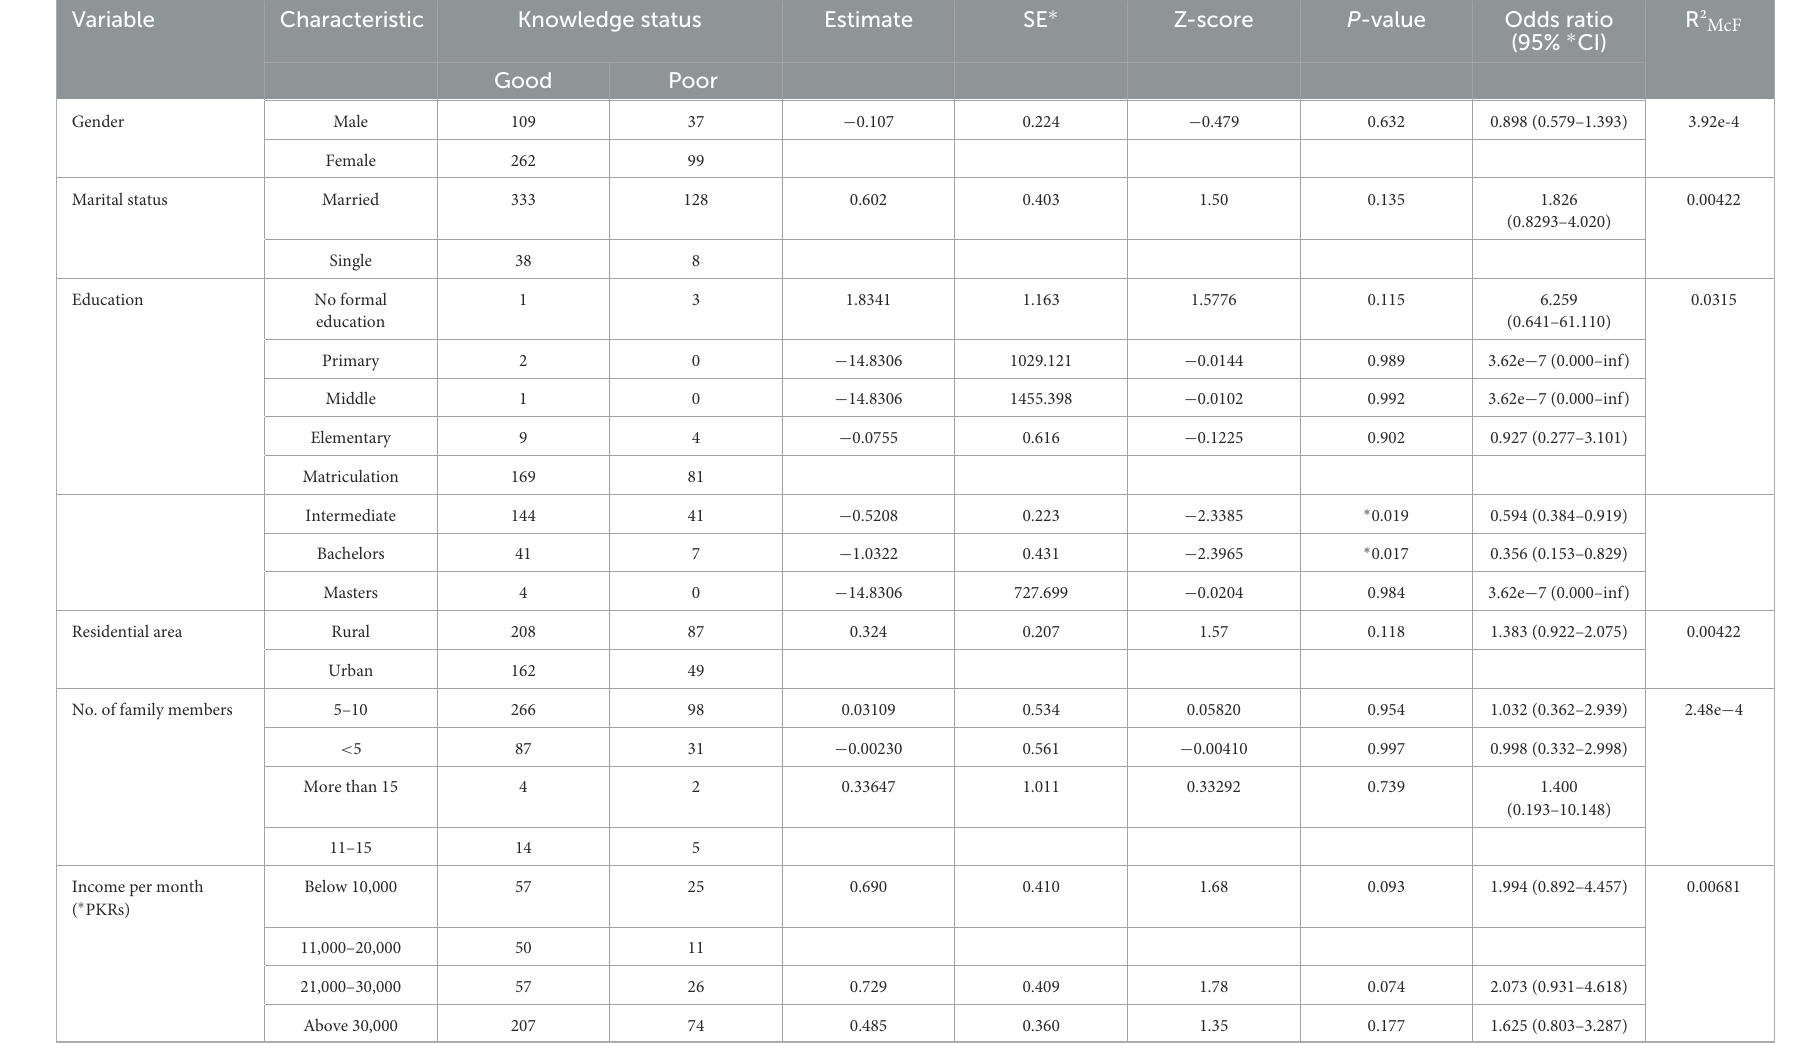
TABLE 6 Associations between participants’ knowledge and socio-demographic characteristics.